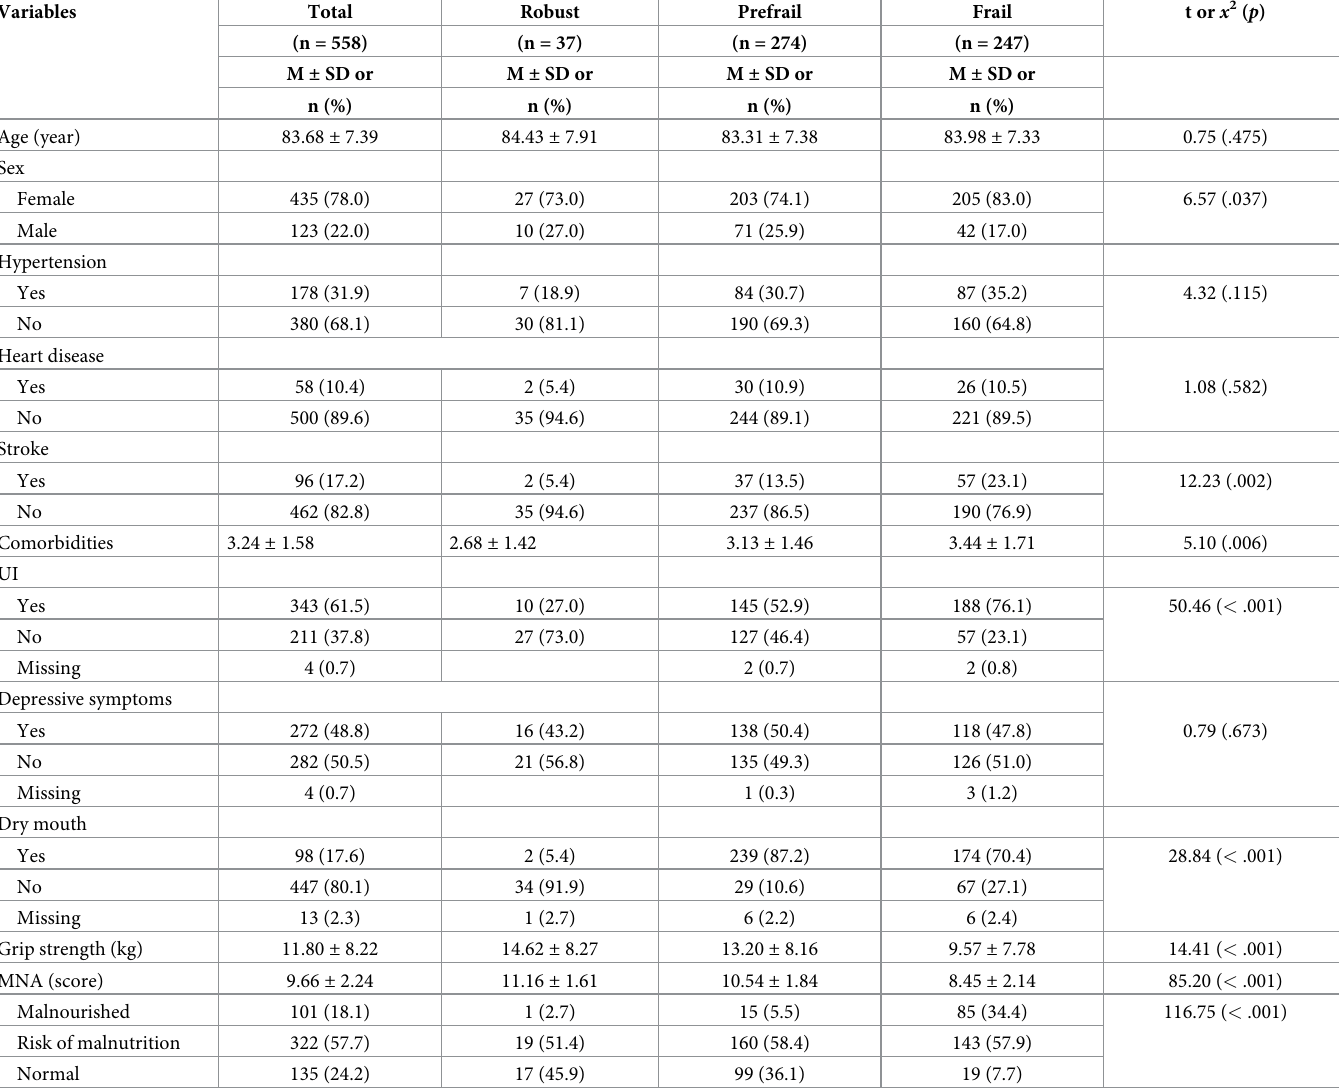
Table 1. Characteristics of the participants and differences in the variables among frailty groups (N =